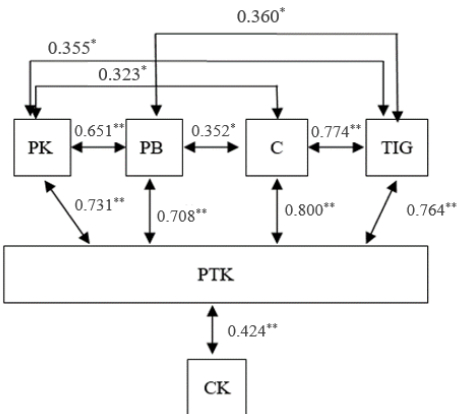
Figure 8. Correlation between the PTK components and PTK itself. PK—Pedagogical Knowledge; PB—Personal Beliefs about the Value of Technology; C—Teachers’ Confidence in using Technology; TIG—Technology Instrumental Genesis; PTK—Pedagogical Technology Knowledge; CK—Knowledge of mathematical content. * p < 0.05; ** p < 0.01.